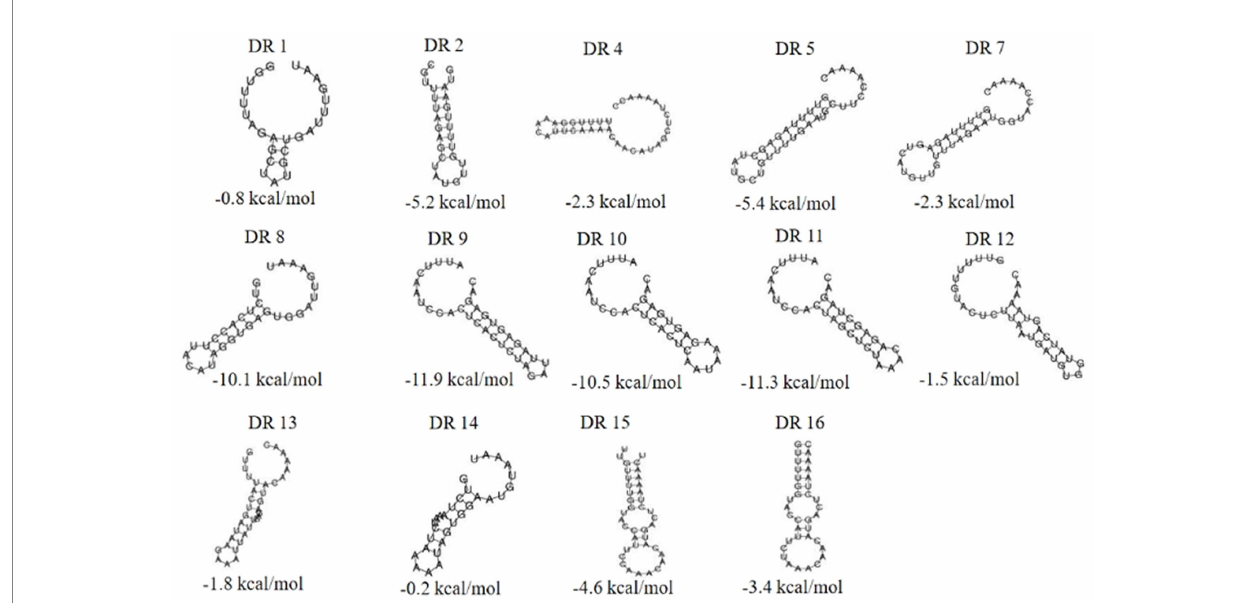
FIGURE 4 The RNA secondary structures and the MFE of the partial (14) repeats. Secondary structure prediction of the 16 repeat sequences by RNAfold and 14 repeat sequences can form structurally conserved dumbbell-shaped RNA secondary structures. The free energy of the thermodynamic ensemble was − 0.8, − 5.2, − 2.3 -5.4, − 2.3, − 10.1, − 11.9, − 10.5, − 11.3, − 1.5, − 1.8 − 0.2, − 4.6, − 3.4